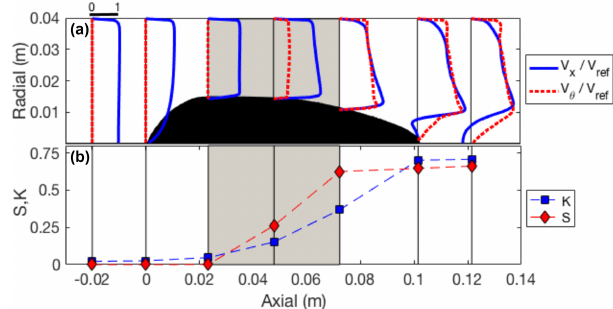
Figure 3. (a) Profiles of axial and tangential velocity ratio at seven stations across the stator, and (b) axial dependence of total loss co- efficient ( K ) and swirl number ( S ). The shaded region indicates the extent of the blade chord and a scale is indicated above the first profile.